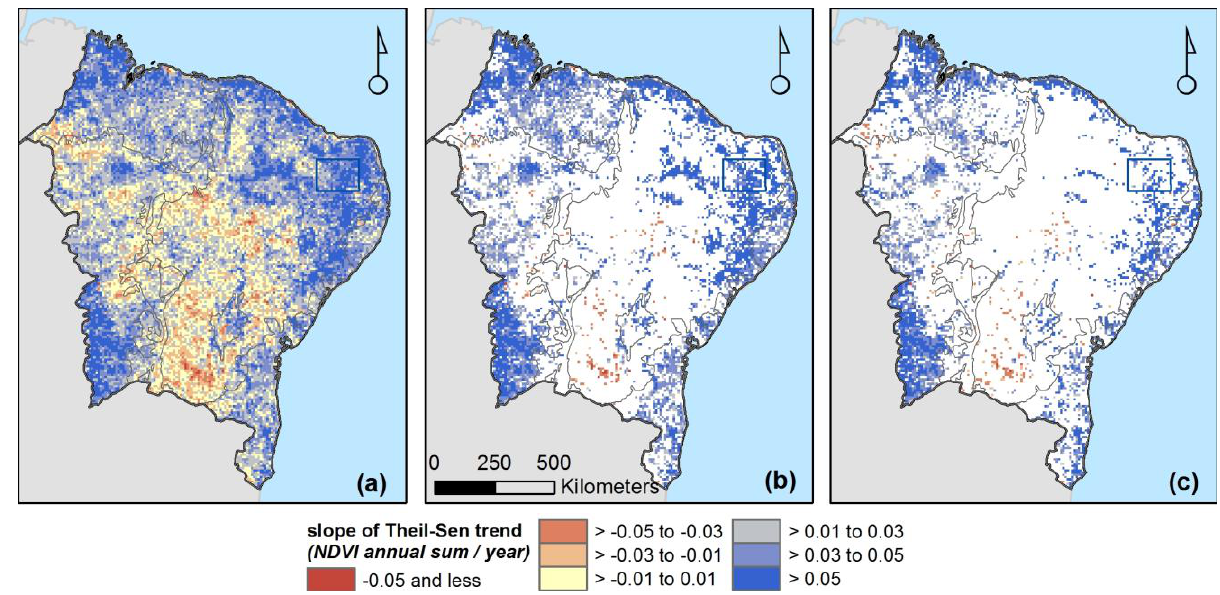
Figure 3 . The results of the inter-annual trend-analysis for annually accumulated NDVI3g time series (1982–2010). ( a ) The slope of the Theil-Sen trend for raw annual NDVI3g data (annual sum); ( b ) the slope of significant trends in raw annual NDVI3g data (annual sum); ( c ) the slope of significant trends in annual NDVI3g data after prewhitening (annual sum) (white = no significance, p < 0.05). Grey lines represent the outlines of the biomes from Figure